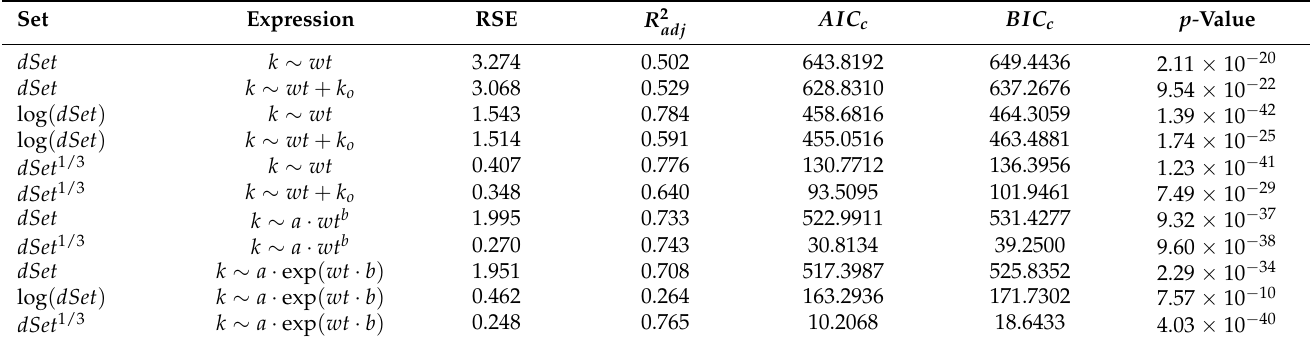
Table 5. Regression results for k vs. wt for the CMC dataset.